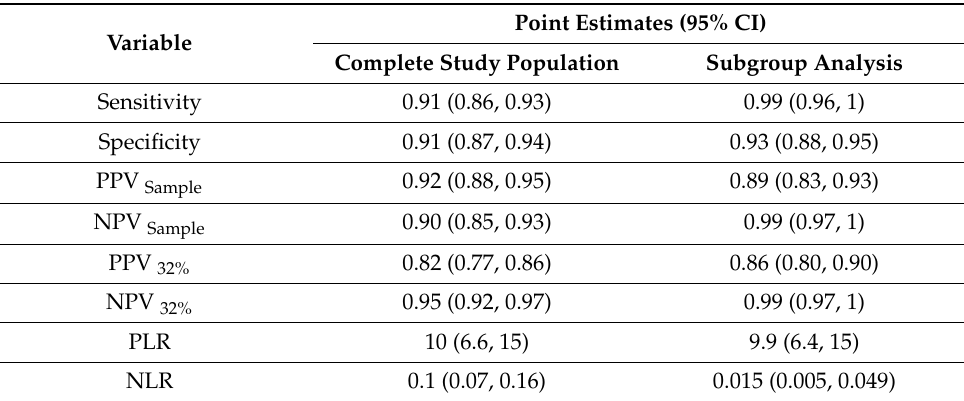
Figure 5. Receiver–operator characteristics. Numbers in brackets represent 95% confidence intervals (CI). Black dot marks the chosen threshold on the curve for the reported. Table 2. Diagnostic accuracy of the Gili lung congestion algorithm.